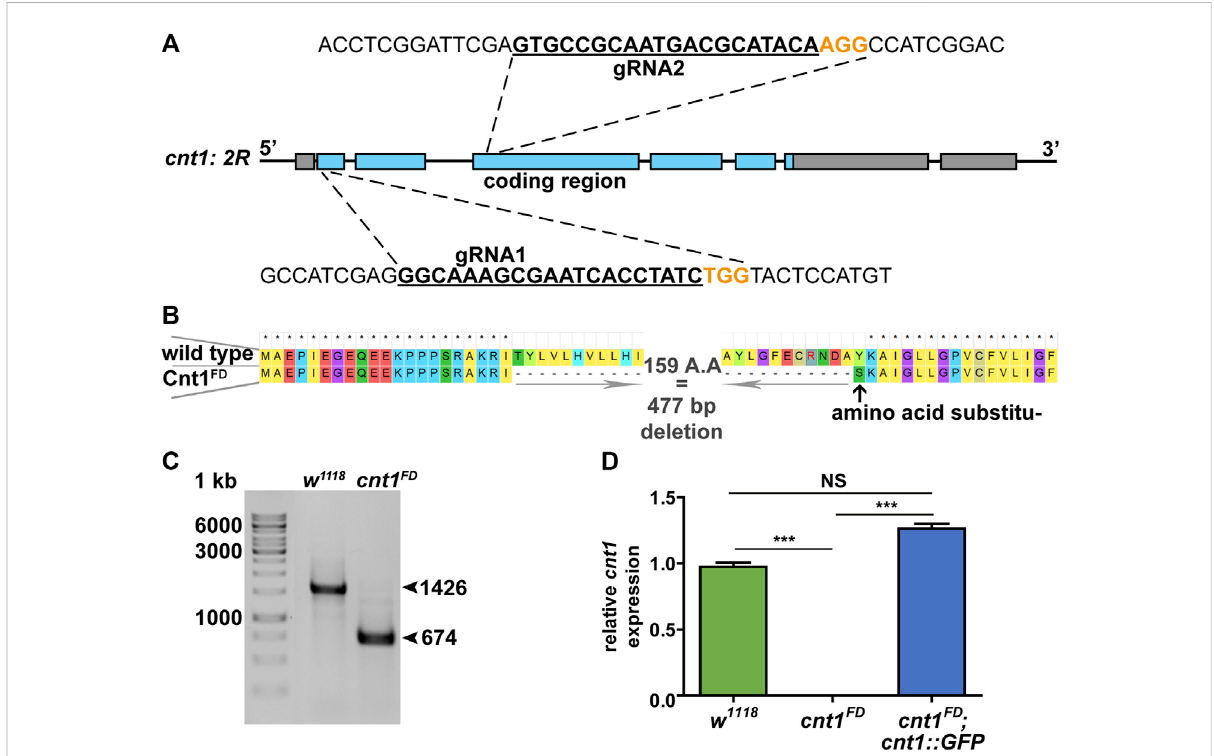
FIGURE 3 Generation of mutation in Drosophila cnt1 . (A) Schematic representation of the cnt1 mutation using two guide RNAs (gRNA); the target of the fi rst gRNA is located in the fi rst coding exon and the second in the third coding exon. (B) Protein sequence alignment of Cnt1 in control w 1118 and cnt1 FD . The mutation caused adeletionof 477 bp (159 A.A) in thecoding region of cnt1 gene (a total of752 bp including introns) and a substitutionof the tyrosine residue for serine. (C) The PCR products of the cnt1 mutant compared with its control. (D) Results of RT-qPCR analysis showing a relative expression of cnt1 in control fl ies, cnt1 FD mutant fl ies, and rescue fl ies cnt1 FD ;cnt1::GFP . Expressions were normalized to α Tub84B and act5C transcripts ( ΔΔ CT). Signi fi cance was analyzed by one-way analysis of variance (ANOVA) and labeled as follows: *** p < 0.001, NS > 0.05; n = 4. Error bars are shown as mean ±